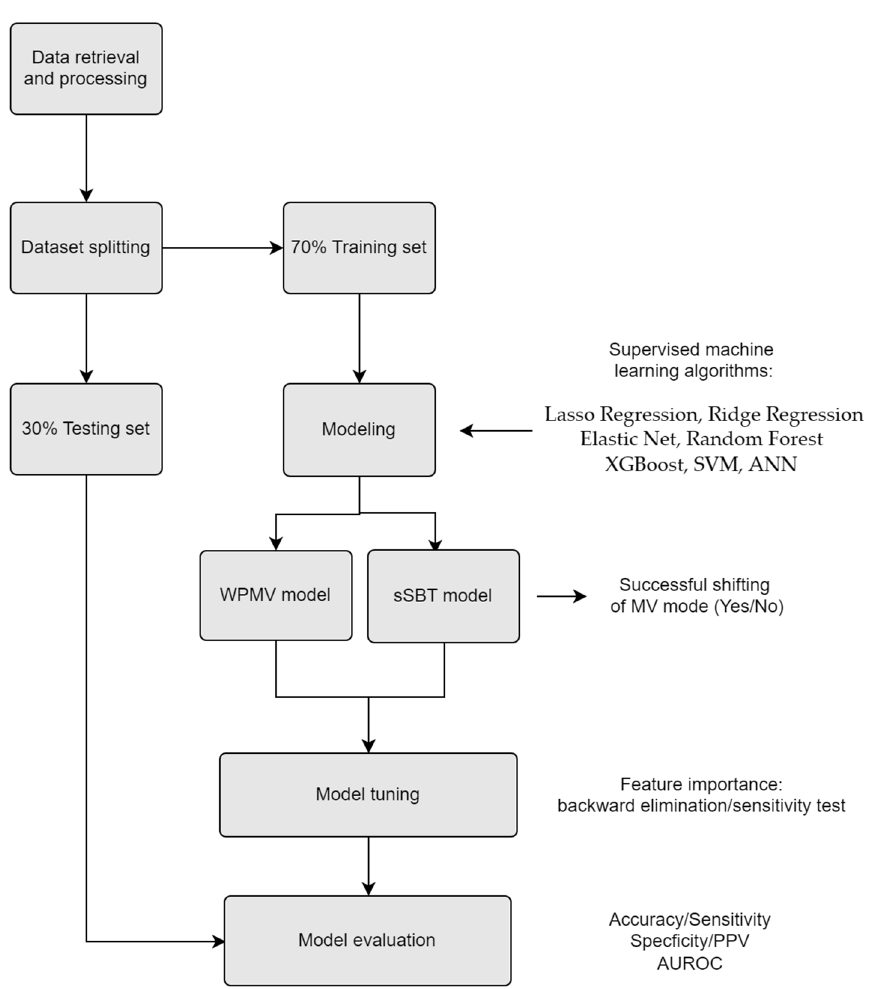
Figure 1. The workflow of our study. XGBoost: Extreme Gradient Boosting, SVM: Support Vector Machine., ANN: Artificial Neural Network. WPMV: weaning probability of mandatory ventilation. sSBT: successful spontaneous breathing trial. MV: mechanical ventilator. PPV: Positive Predictive Value. AUROC: area under the receiver operating characteristic curves.